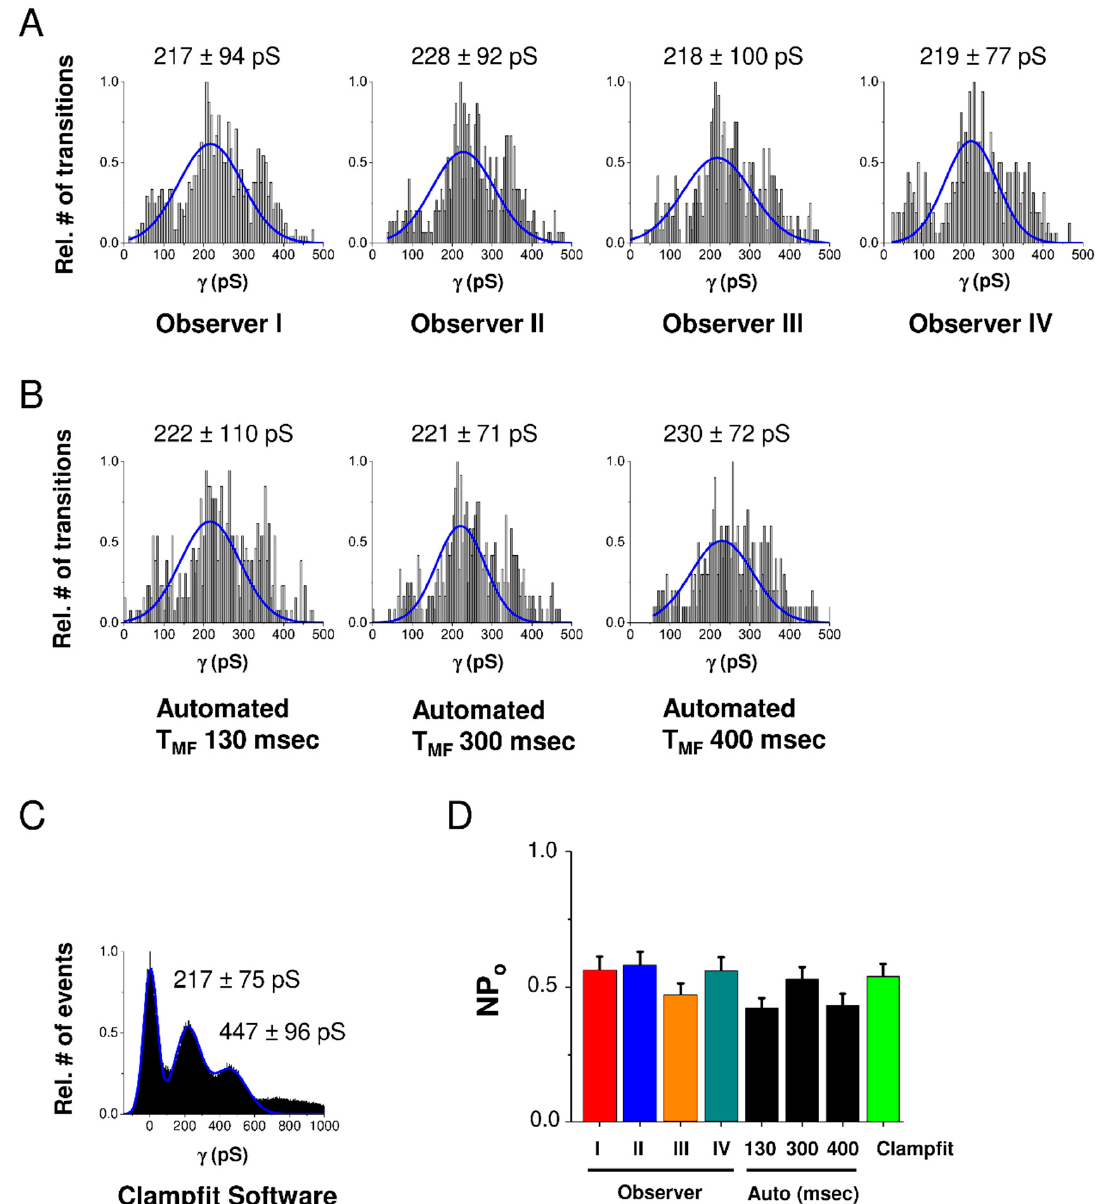
Figure 2. Validation of HemiGUI analysis by comparing results obtained from user intervention analysis, fully automated analysis and analysis by Clampfit software. Experiments were performed on a dataset consisting of 20 current traces randomly selected from HeLa-Cx43 whole-cell recordings involving voltage steps from − 30 mV to +70 mV ( N = 3; N = 4; n = 20). ( A ) All conduction transition histograms were obtained by semi-automated analysis by four independent observers. ( B ) Automated analysis and the effect of different median filter time window (T MF ) sizes. A T MF of 300 ms value based on the slowest transition time observed in the dataset gave a distribution most close to the one observed with semi-automated user intervention-based analysis. ( C ) All-point histogram generated from baseline-corrected traces generated by Clampfit. ( D ) Summary graph of nominal open probability (NPo) data demonstrating no statistically significant differences between Clampfit and the two modes of HemiGUI analysis (one-way ANOVA, Bonferroni post-test).